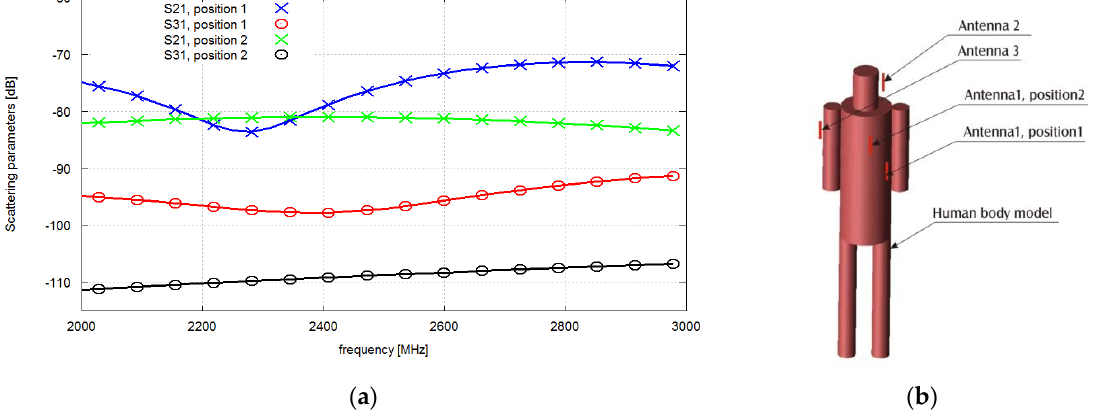
Figure 4 . Scattering matrix parameter vs. frequency ( a ) and position of the chest node ( b ).